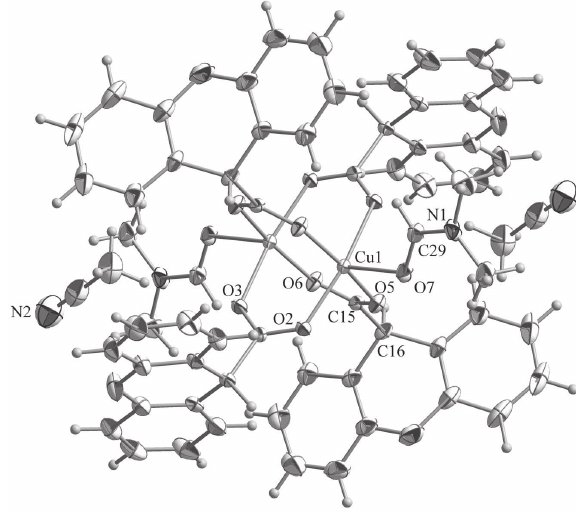
Table 1: Data collection and handling.